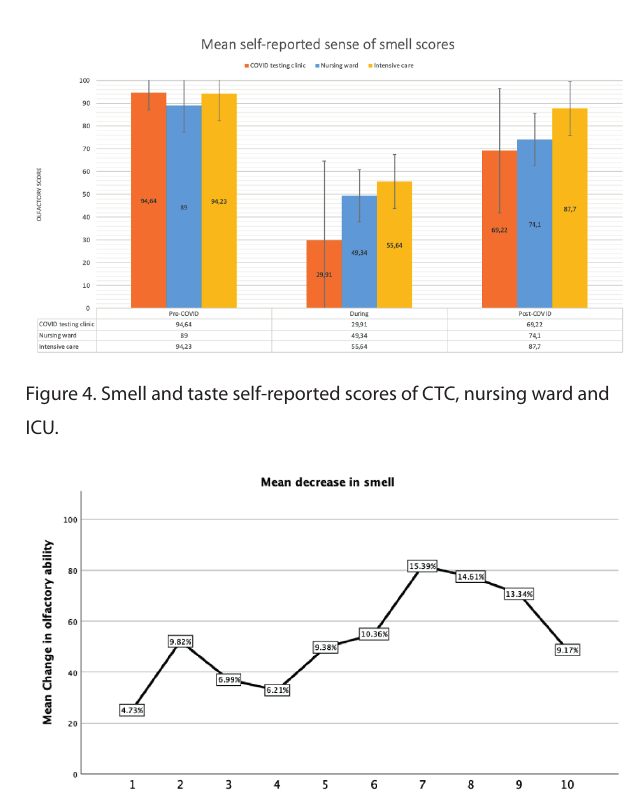
Figure 3. Overall smell and taste self-reported scores after 6 months.